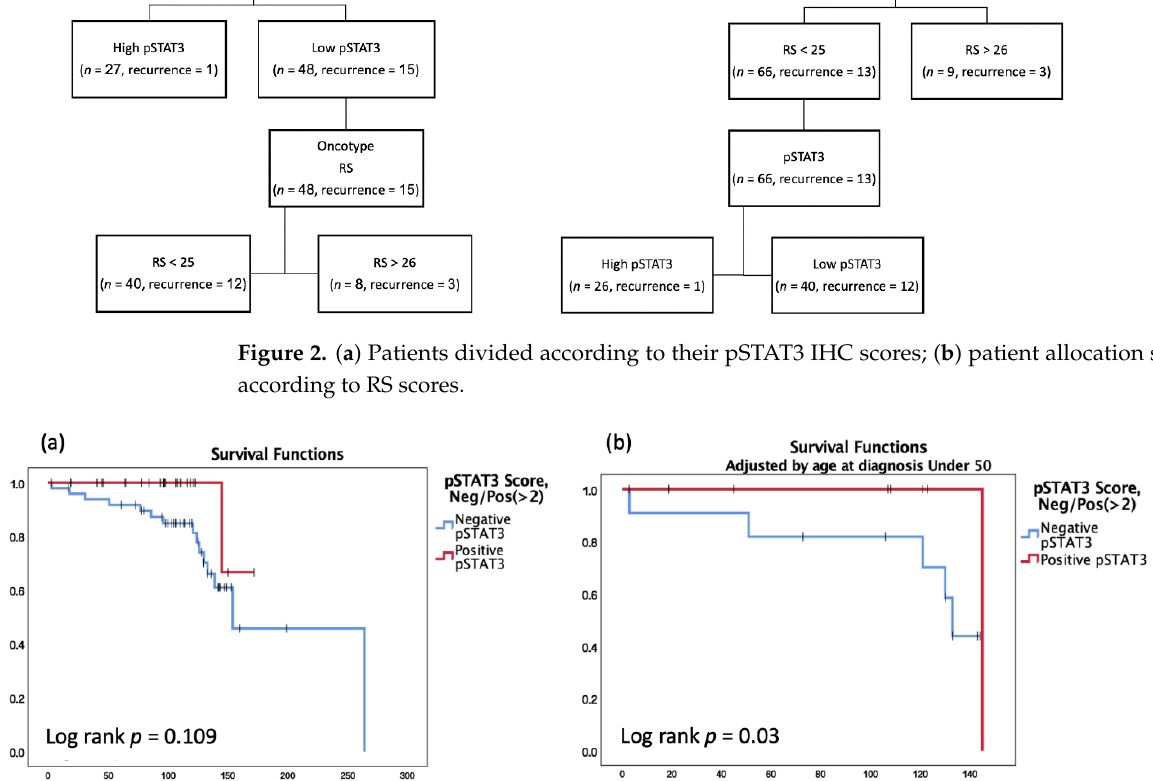
Figure 2. ( a ) Patients divided according to their pSTAT3 IHC scores; ( b ) patient allocation started according to RS scores.